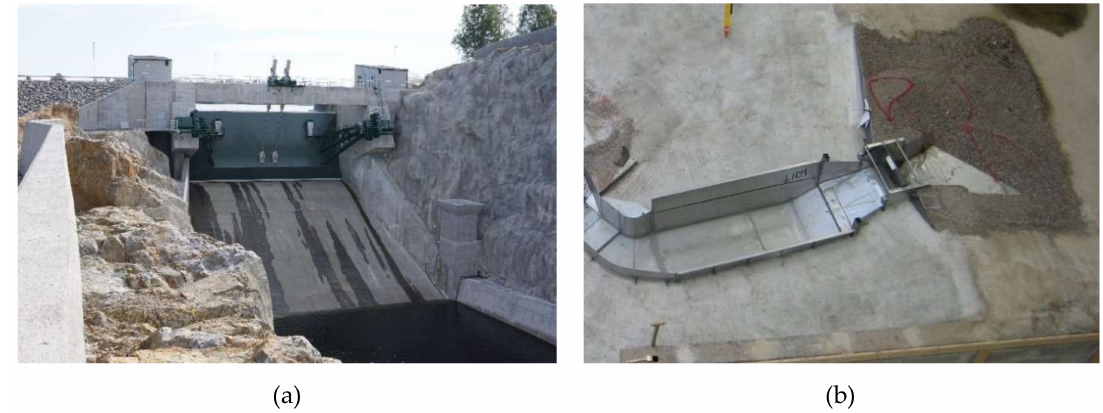
Figure 5. Bergeforsen spillway: ( a ) Prototype (© Vattenfall); ( b ) Scale model, λ = 50.